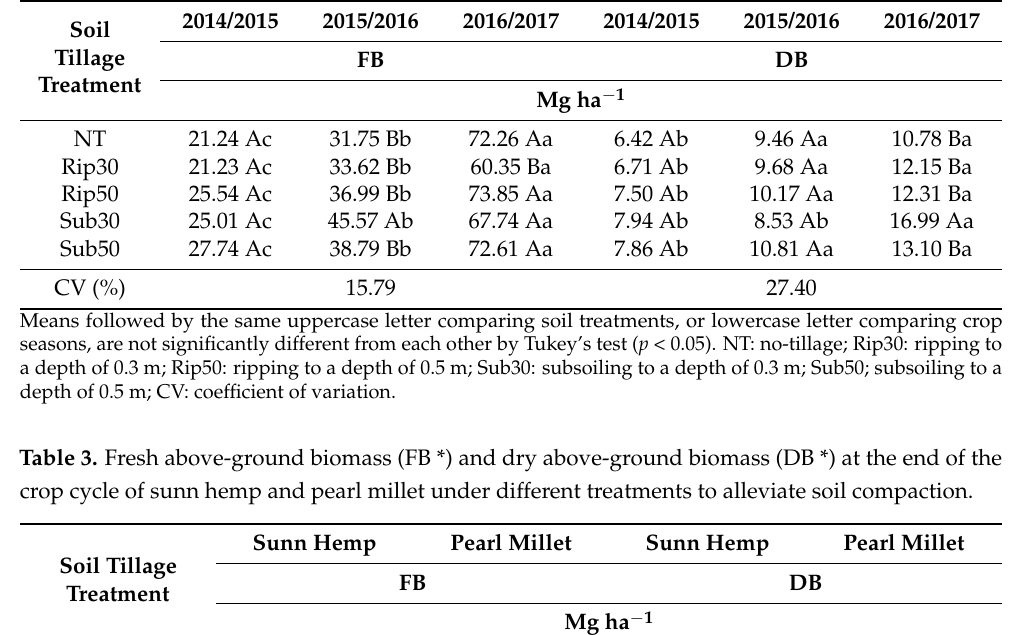
Table 2. Fresh above-ground biomass (FB) and dry above-ground biomass (DB) of cover crops at the end of the crop cycle in different treatments for soil compaction alleviation in three consecutive crop seasons.